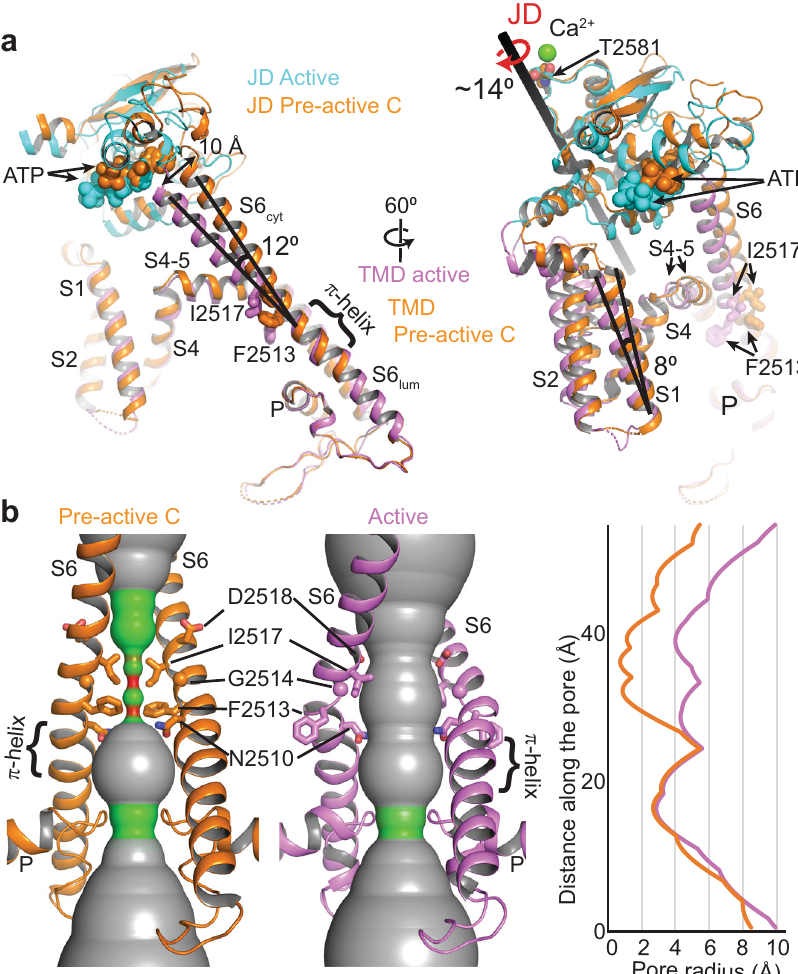
Fig. 5 Structure of the IP 3 R-3 in the open conformation. a Comparison of the hIP 3 R-3 structures in the pre-active C and active conformations aligned as in Fig. 2. b Ion permeation pathways of hIP 3 R-3 in pre-active C and active conformations (radii coloring: red, <0.8 Å; green, 0.8-4.0 Å; gray, >4.0 Å) along with the 1D graph of the pore radius. The JD and TMD of the active state are shown in cyan and violet, respectively. The pre-active C structure is colored